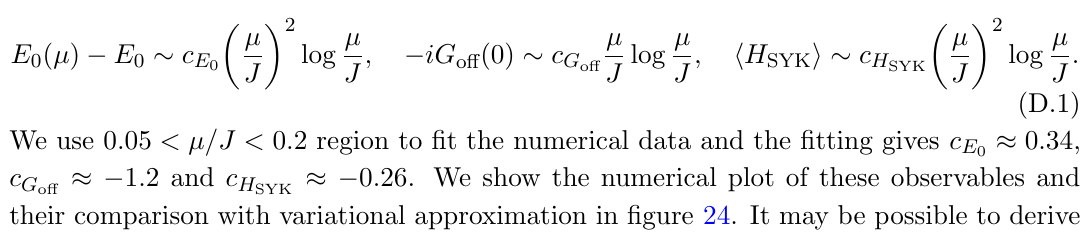
Figure 24 . The plot of observables both in the exact ground state approximation B s ( (cid:12) ( (cid:22) )) . Here we choose the parameter to be q = 4 and J = 1. As written in the j i central picture, the solid lines represent the numerics and the dashed lines represent the conformal limit answer. Left: the plot of the ground state E 0 as a function of (cid:22) . Middle: the plot of the half of the absolute value of the spin operator expectation value o(cid:11) diagonal correlation function iG o(cid:11) (0), as a function of (cid:22) . Right: the plot of the energy in the (cid:0) SYK Hamiltonian H SYK as a function of (cid:22) h i